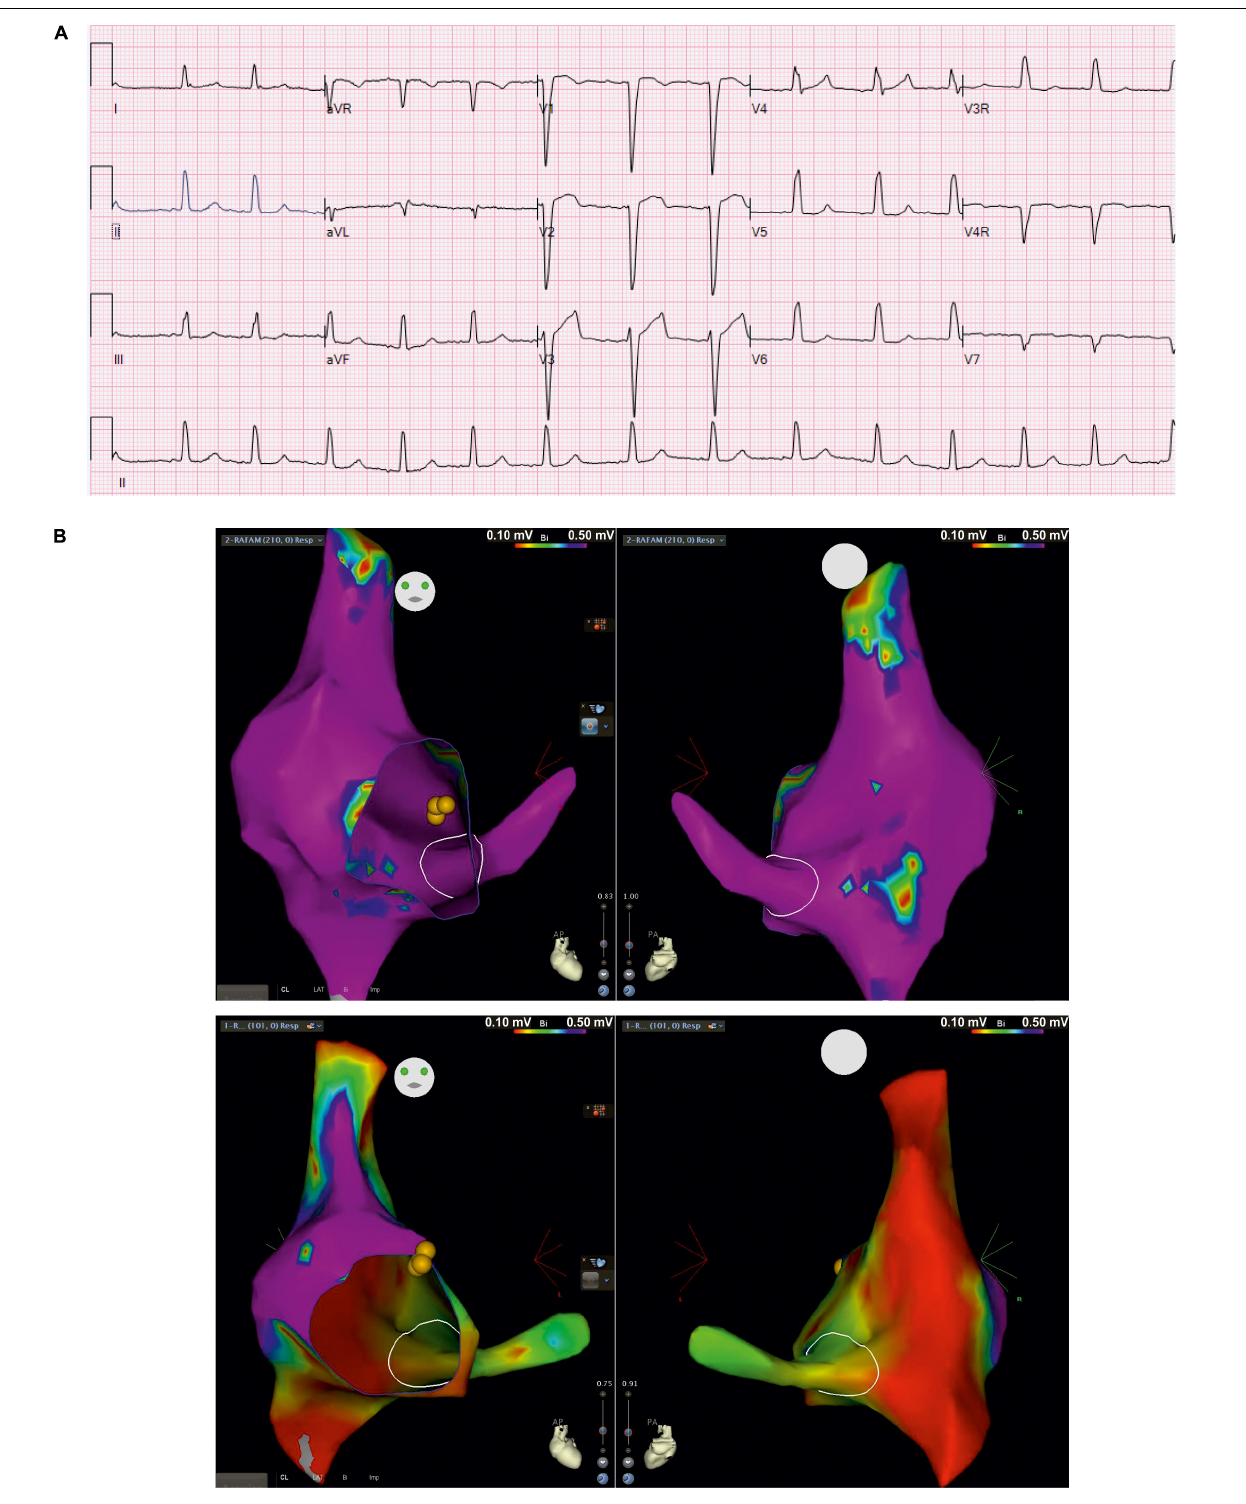
FIGURE 2 | Surface electrocardiogram and intracardiac three-dimensional voltage mapping. (A) Resting surface electrocardiograms (ECG) at 5 years of age in index patient at 25 mm/second, 10 mm/mV; (B) Antero-posterior (left) and postero-anterior (right) projections of voltage map of right atrium and coronary sinus in baseline rhythm from index patient (top) and, healthy age-matched peer (bottom) for comparison (voltage color scale range: 0.1 – 0.5 mV, “purple” indicates voltage > 0.5 mV)